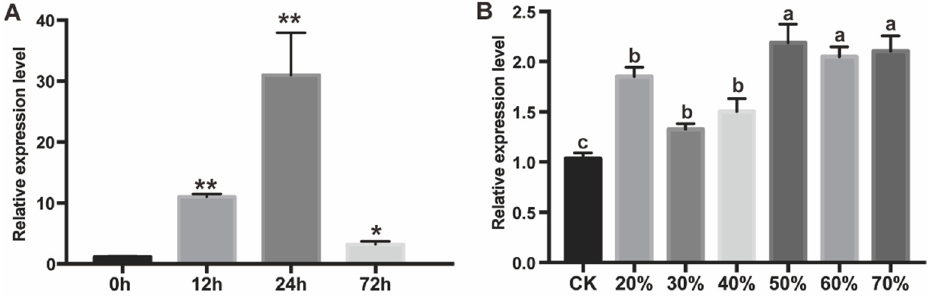
Figure 2. Expression patterns of PtAOS1 in response to jasmonic acid (JA) ( A ); and drought ( B ). Data are shown as mean ± SD of three replicates. CK, control samples under well-watered condition. Asterisks indicate significant differences between treatment and control (*, p < 0.05 and **, p < 0.01). Different letters above the columns indicate significant differences at p < 0.05.